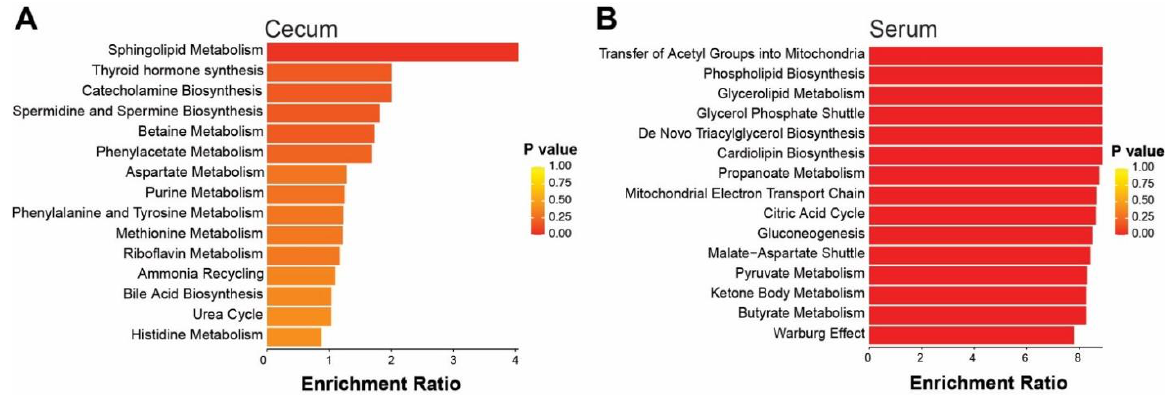
Figure 8. Metabolic pathways (top 15) in the ( A ) cecum and ( B ) serum associated with enriched metabolites in mice exposed to cold (8 °C) or thermoneutral (30 °C) temperatures. Quantitative enrichment analysis was performed on identified metabolites in the cecum (n = 108) and serum (n = 75) using MetaboAnalyst v5.0.